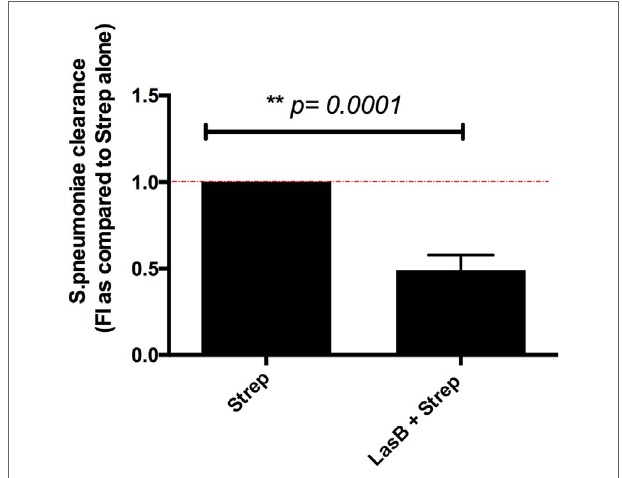
FigUre 10 | Analysis of Streptococcus pneumoniae clearance by MPI cells following purified LasB treatment. MPI cells were plated as described in Figure 4 ( n = 3). They were incubated for 2 h with either medium alone (serum-free RPMI) or medium supplemented with 50 nM recombinant LasB. After washing, cells were infected in serum-free RPMI with S. pneumoniae (MOI 1) for 4 h. In parallel, the bacterial inoculum was seeded at T0 in the absence of macrophages as a control of bacterial growth. For bacterial count and bacterial clearance measurements, supernatants were collected and cells were lysed in PBS-Triton as explained in Section “Materials and Methods.” 100 µL of each treatment (at various dilutions) were spread on THYB-Agar plates and left 48 h at 37°C, 5% CO 2 for CFU count. As in Figure 4 , a value of 1 was given to the maximal bacterial clearance obtained with the S. pneumoniae alone, and the LasB + S. p treatment was then expressed relative to 1. Results are expressed as mean ± SEM, and statistical significance analyzed with t